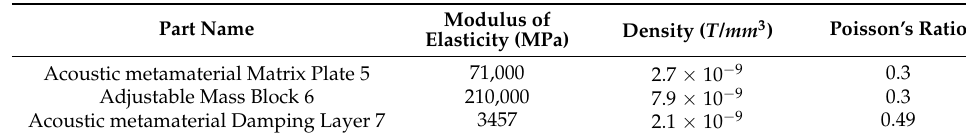
Table 3. Properties of acoustic metamaterial materials.